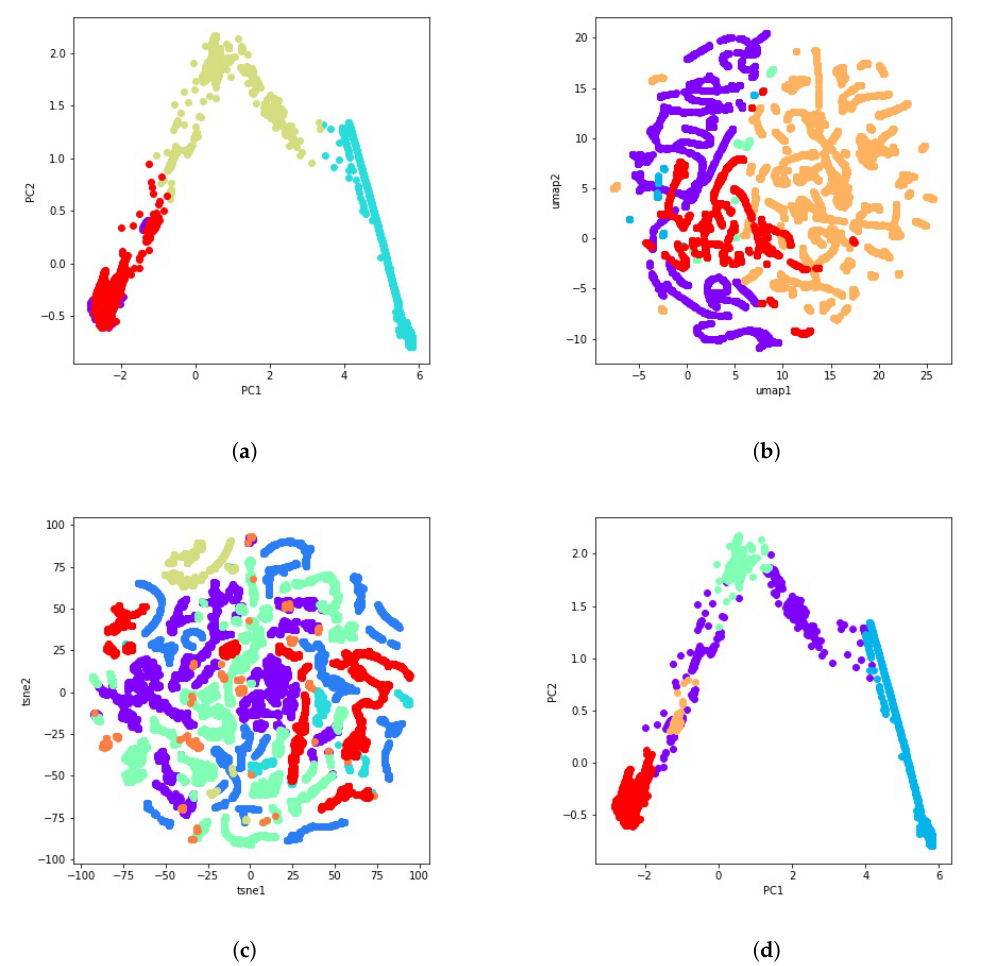
Figure 6. Some examples of the 51 calculated clustering solutions using PCA, t-SNE and UMAP. ( a ) PCA visualization of the K-means clustering result with 4 clusters. ( b ) UMAP visualization of the agglomerative clustering result with average linkage and Euclidean distance. ( c ) t-SNE visualization of the GMM clustering result with 3 components. ( d ) PCA visualization of the HDBSCAN clustering result with min _ samples =